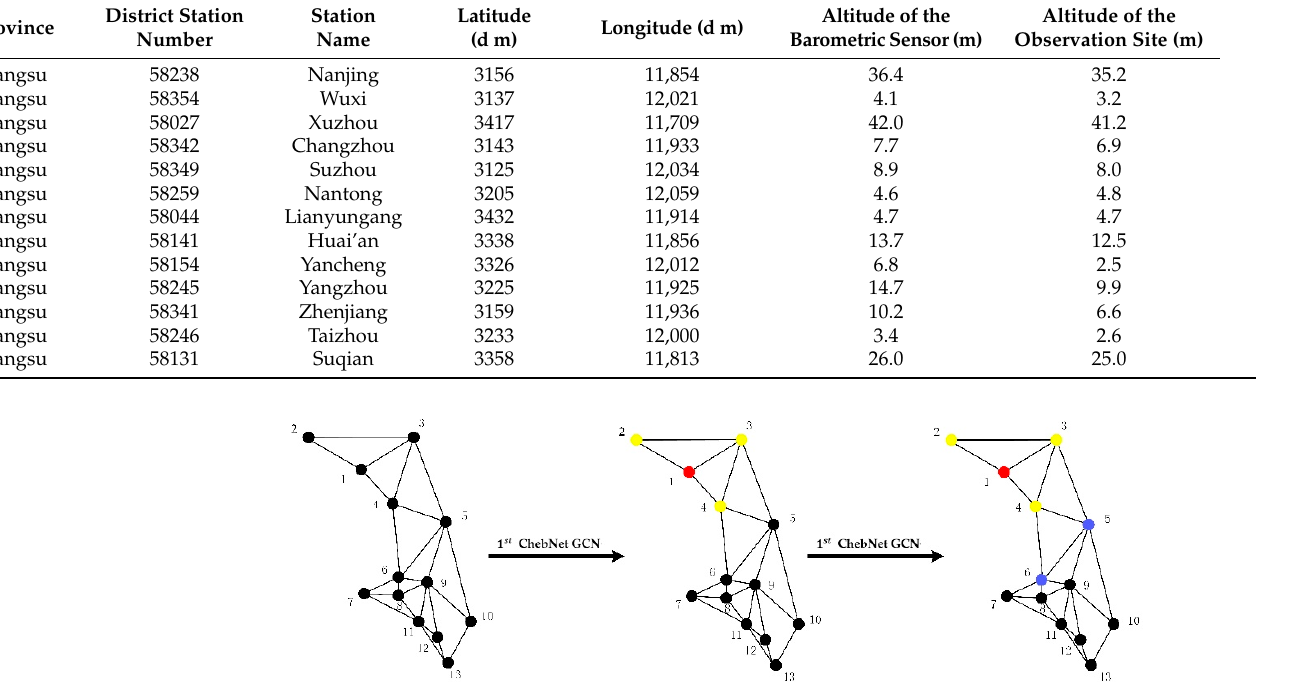
Figure 3. First-order GCN implementation process.